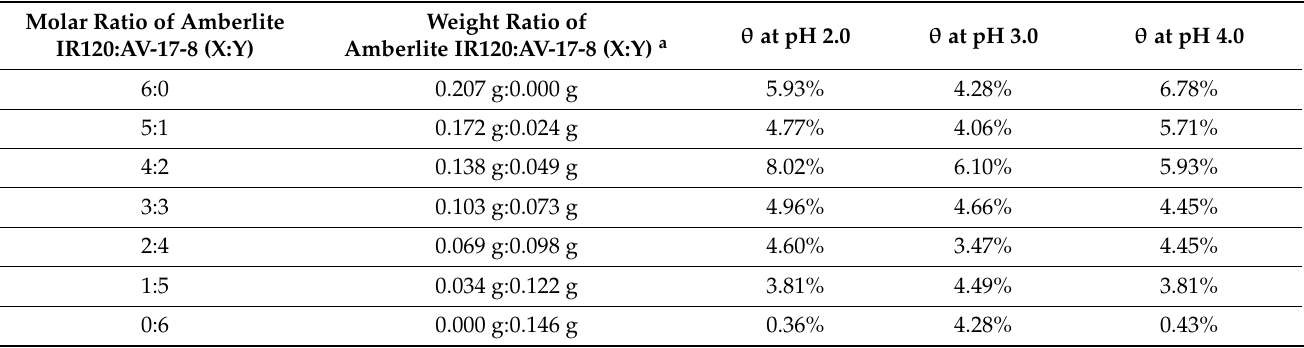
Table 1. The polymer chain binding degree ( θ , %) of cerium ions by the interpolymer system Amberlite IR120:AV-17-8 according to the molar and weight ratios (X:Y) and pH values of the solutions (T = 25 °C).